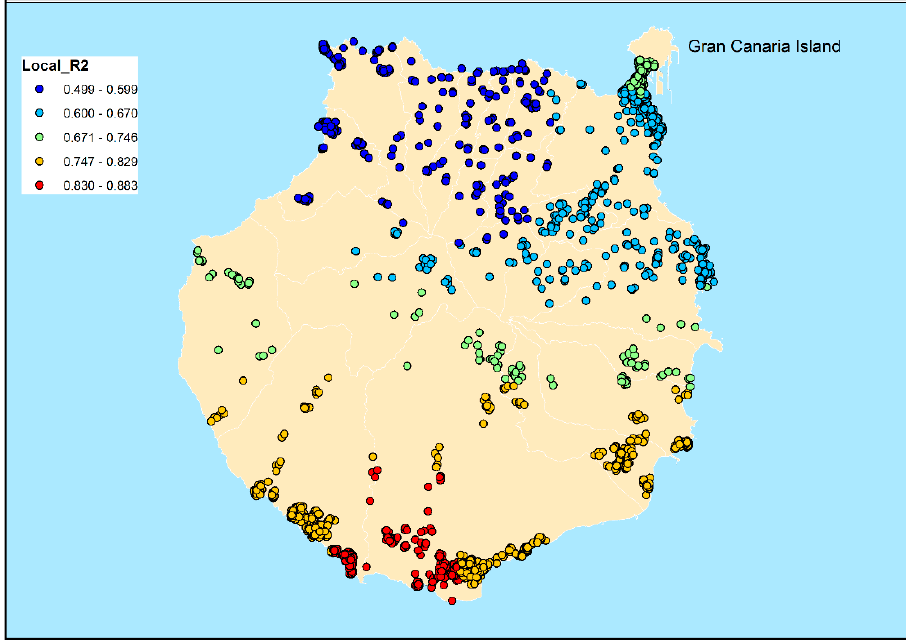
Figure 8. Local R 2 distribution (SW-GWR model).